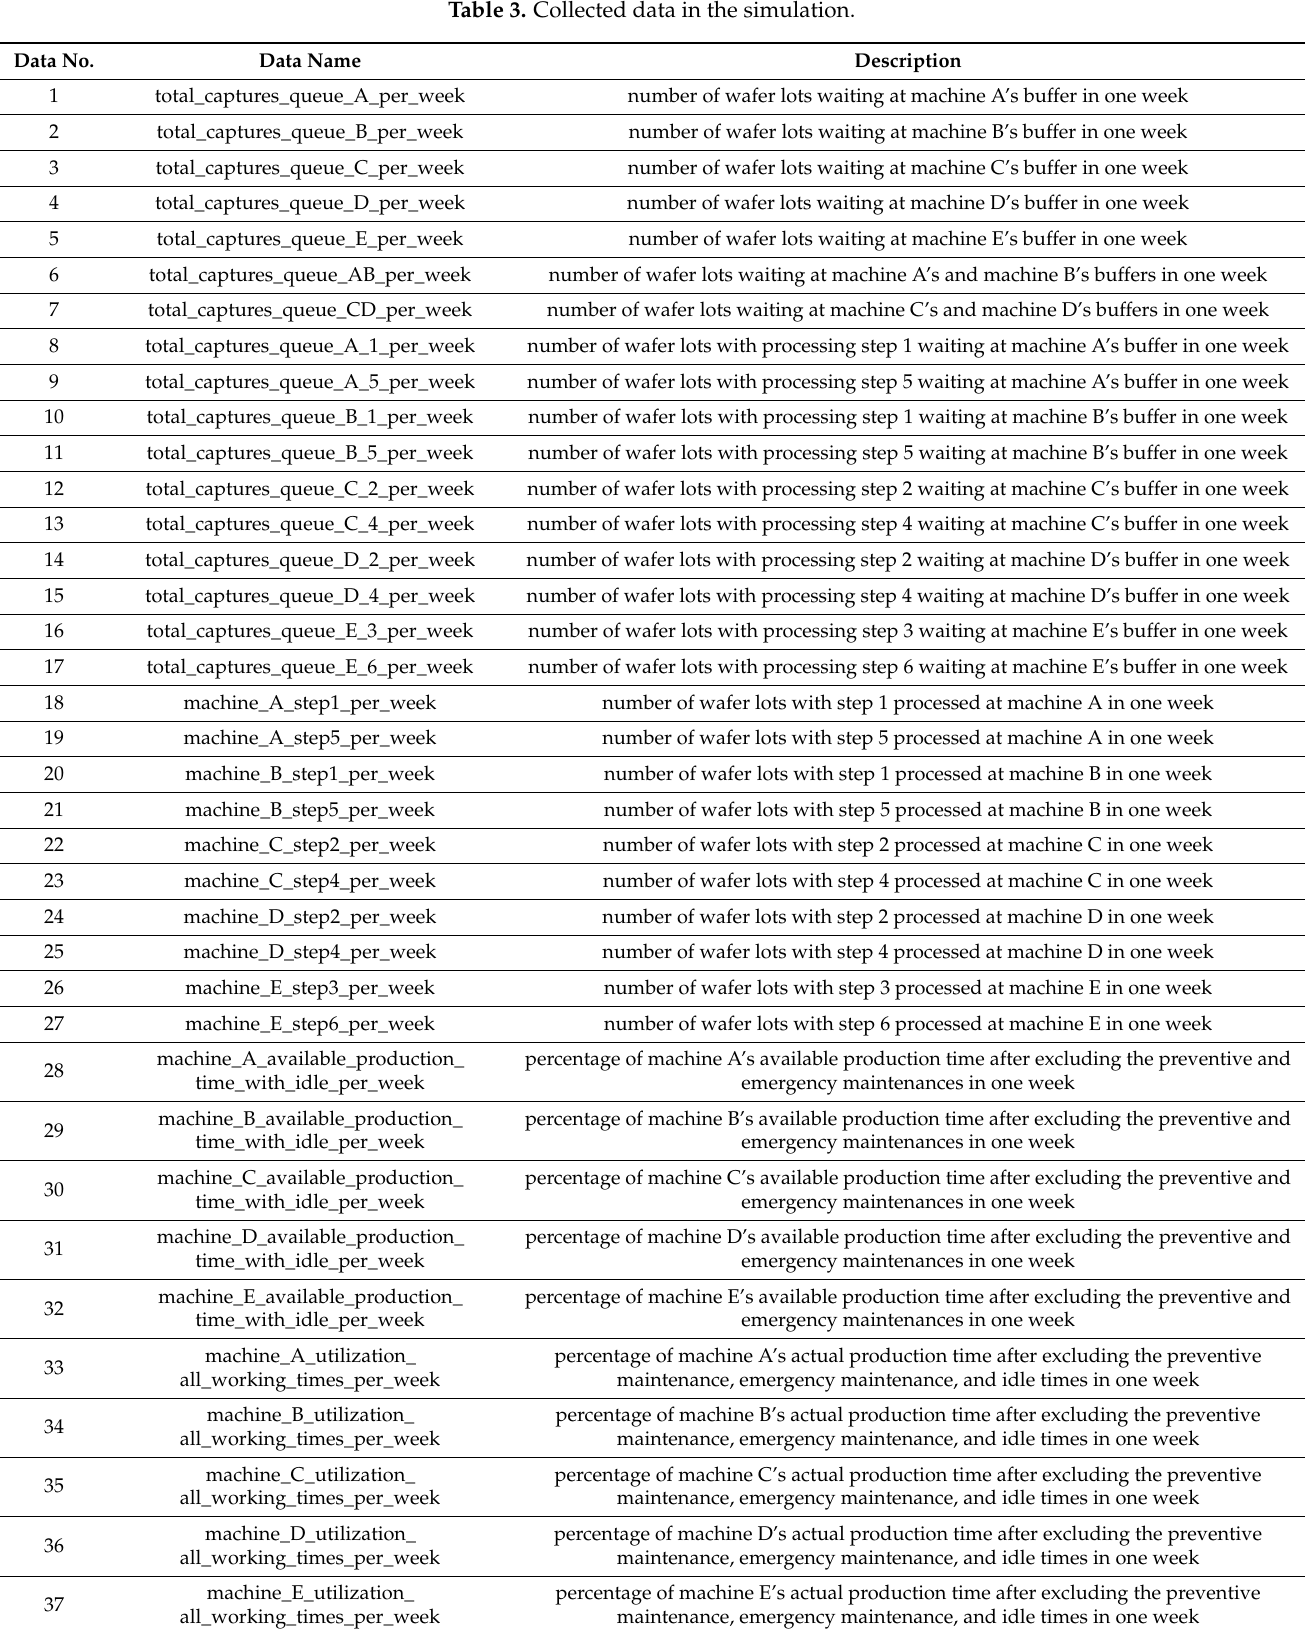
Table 3. Collected data in the